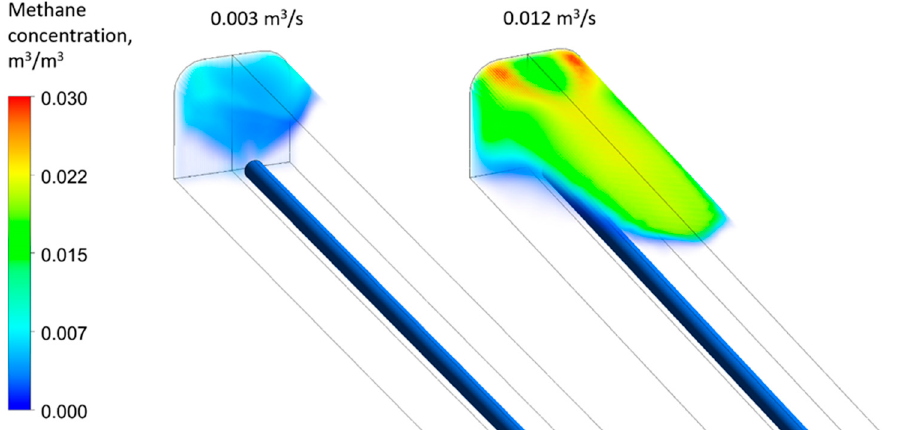
Figure 5. Volume distribution of methane concentrations in a dead ‐ end drift at different methane emission rates.